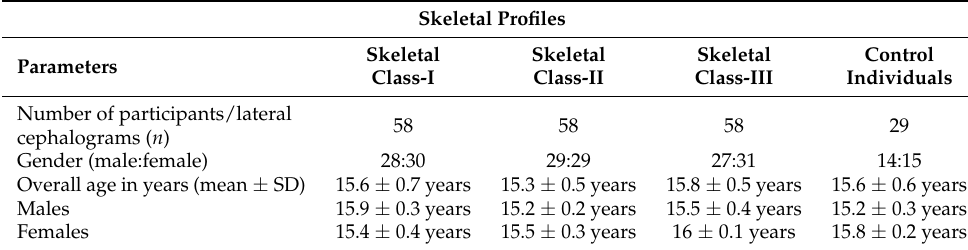
Table 1. Demographics derived from patients’ dental records.